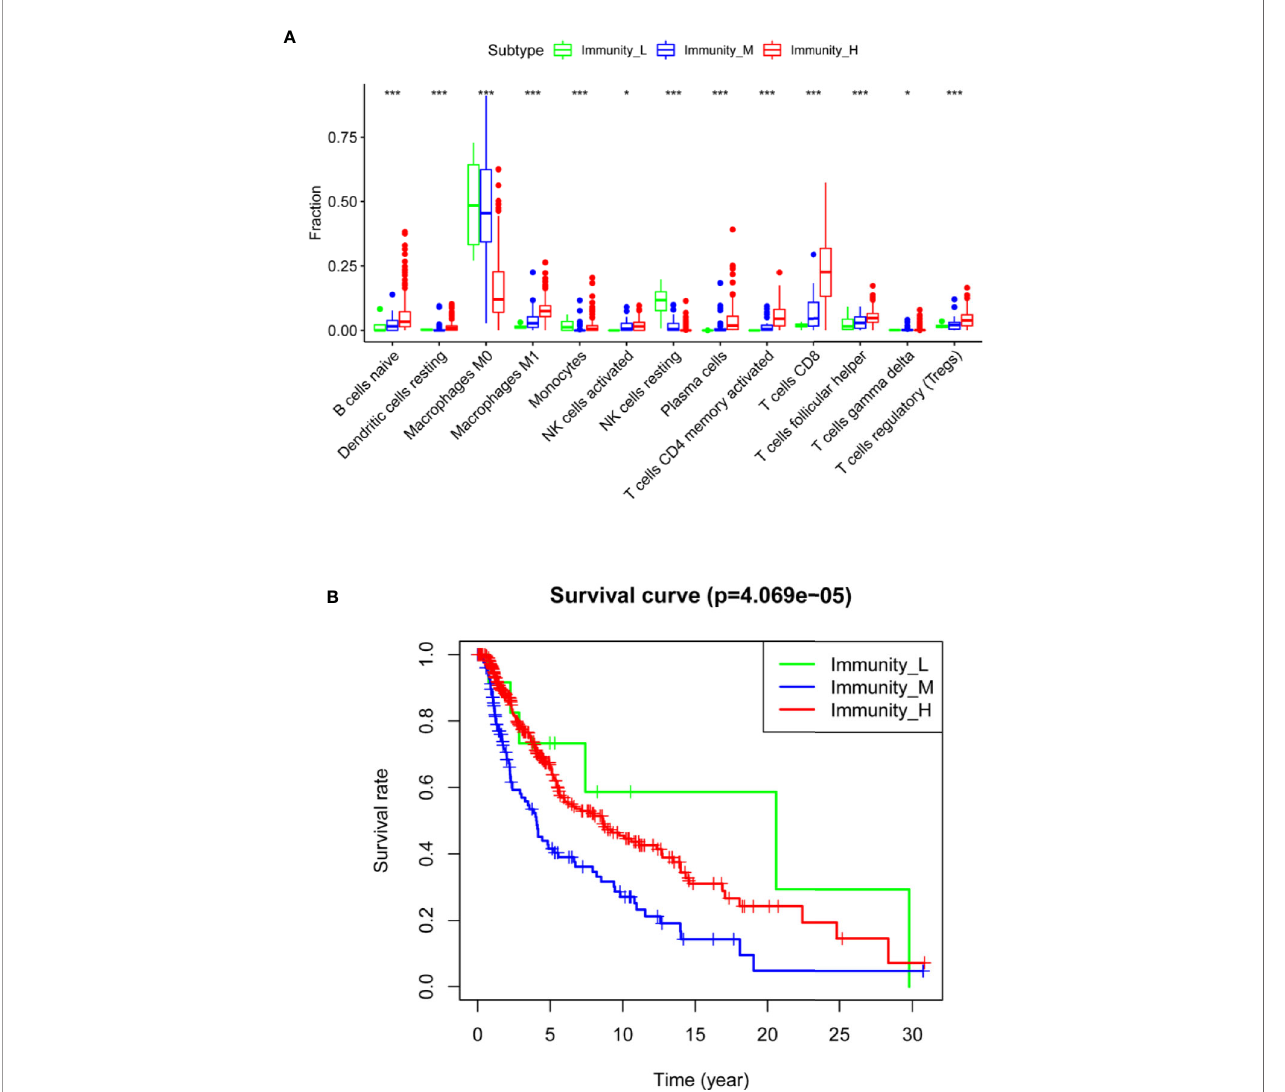
FIGURE 4 | Comparison of immune cell in fi ltration and clinical outcomes between cutaneous melanoma subtypes. (A) Comparison of immune cell in fi ltration in three subtypes (ANOVA test). (B) Comparison of survival prognosis between three subtypes (log-rank test). * P < 0.05, *** P <